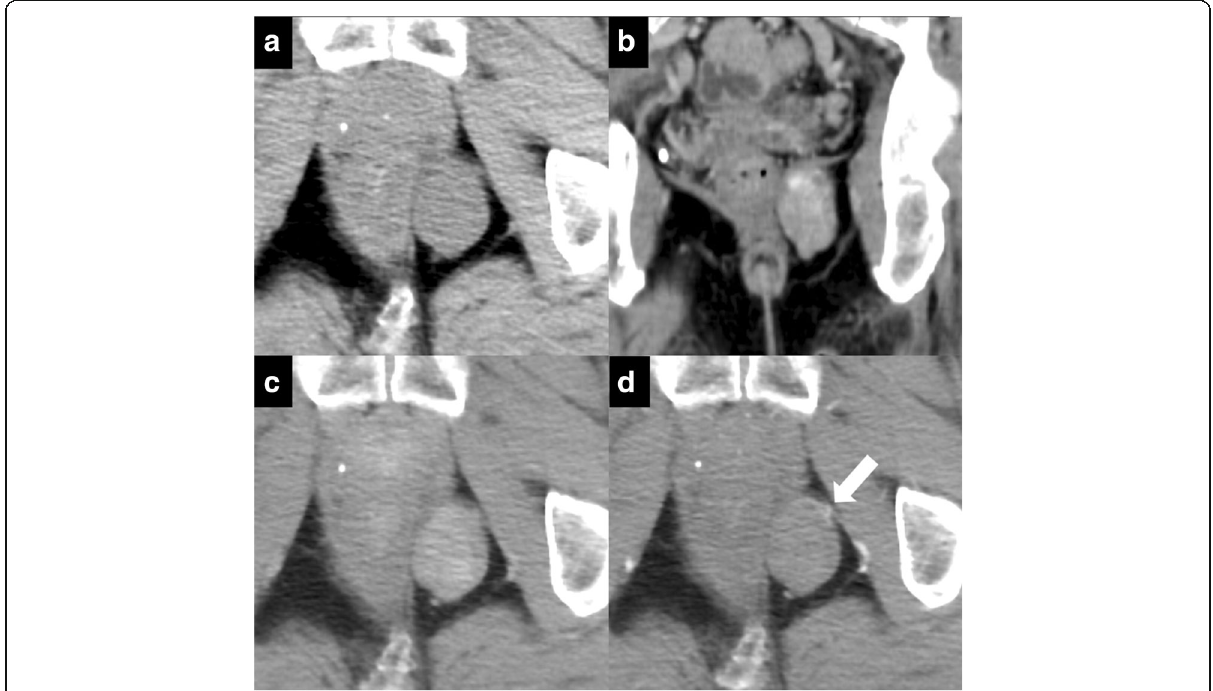
Fig. 1 Axial and reconstruction of coronal contrast-enhanced CT. a A 5-cm, well-defined solid mass in the left ischiorectal fossa abutting the left anal wall and extending into the inferior perineum. b Coronal image: contrast-enhanced CT showing intense heterogeneous enhancement. c Axial image in the delayed phase. Delayed persistence of the mass is revealed. d Axial image in the early phase. A feeding vessel is seen near the mass (white